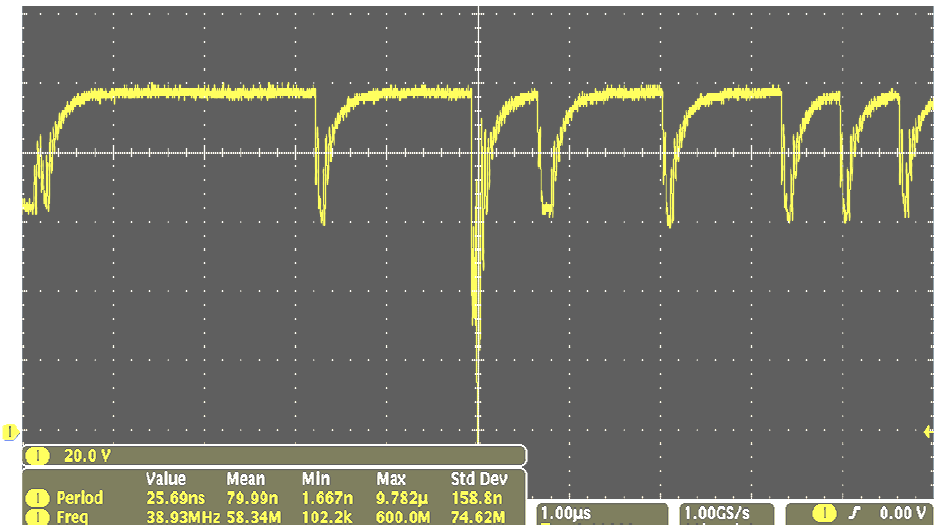
Figure Error! No text of specified style in document.8: Immature discharges at C = 100 pF and V = 100 V